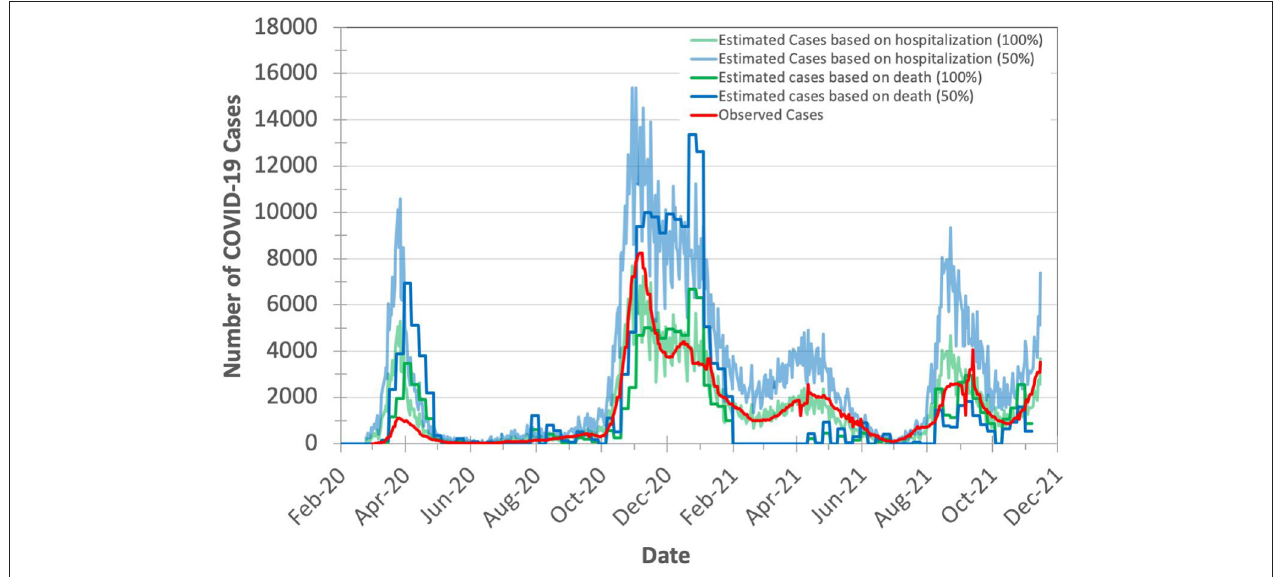
FIGURE 4 | Observed (officially reported) and expected number of COVID-19 cases in Switzerland during the years 2020 and 2021. We calculate the expected number of cases based on both the hospitalizations-to-cases and deaths-to-cases ratios for the second wave. We assume two certainty rate levels of 50 and 100%.